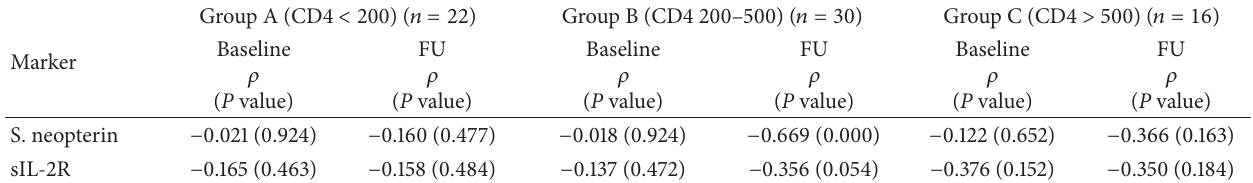
Table 3: Correlation of neopterin and sIL-2R with CD4 count at baseline and followup in the three groups.